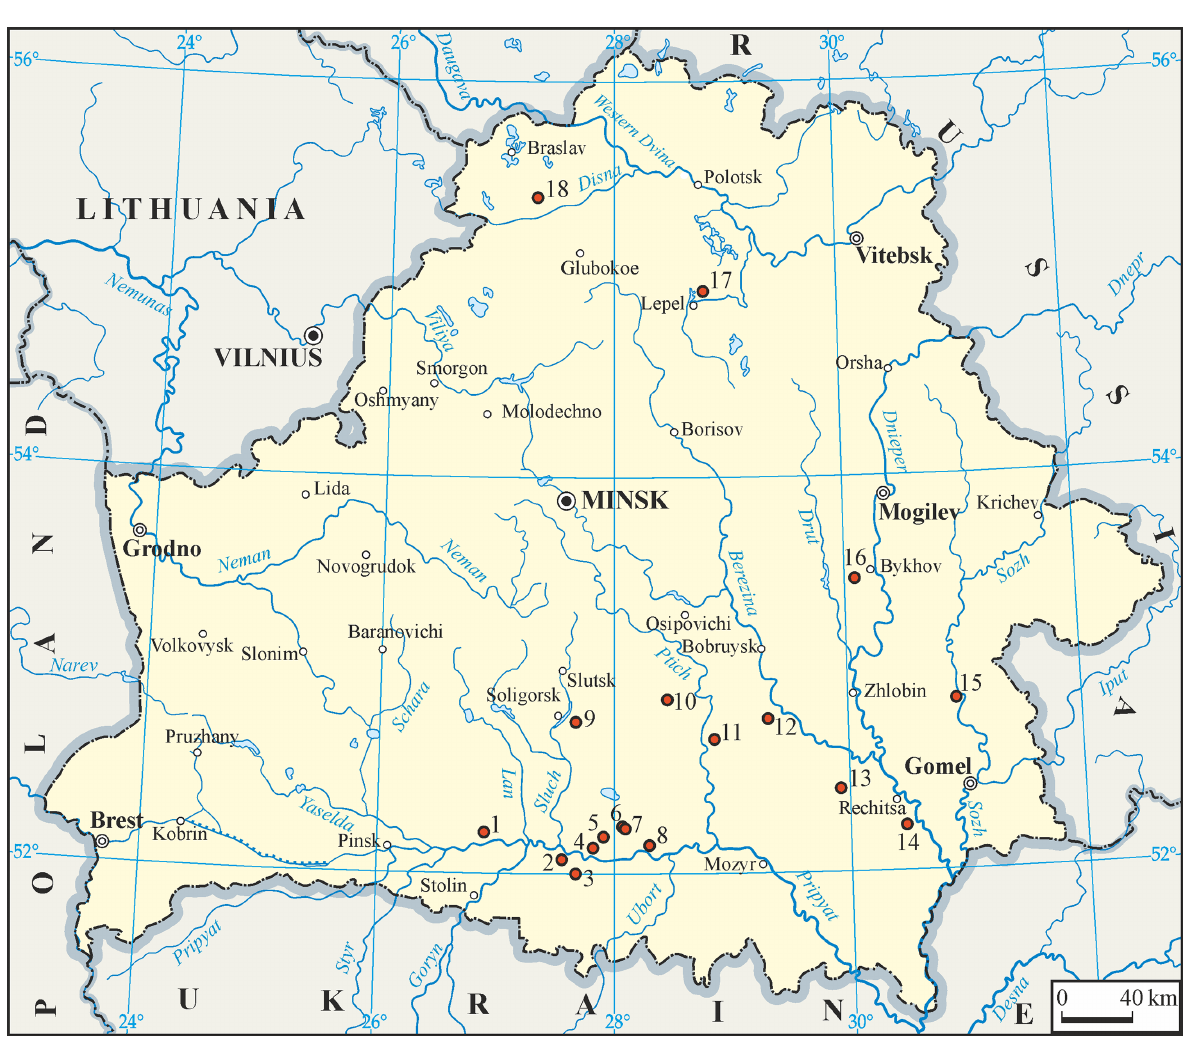
Fig. 1. Location of the studied drill core sections (grey circles) in Belarus: 1, Pinsk-26; 2, Turov-5; 3, Berzhetsy-475; 4, 441; 5, Turov-106; 6, Brinev-6; 7, 506; 8, 331; 9, Starobin-239; 10, Glusk-1; 11, 482; 12, Knyshevichi-7; 13, Ostashkovichi-2R; 14, Krasnoselskaya-215; 15, Berdyzh-1; 16, Bykhov-151; 17, Lepel-1; 18, Buda